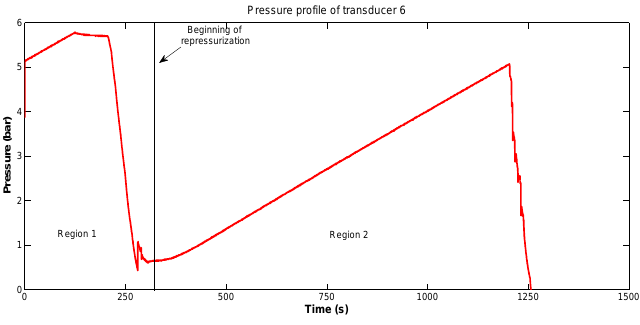
Figure 9. Pressure profile of transducer 6. Source: By authors.